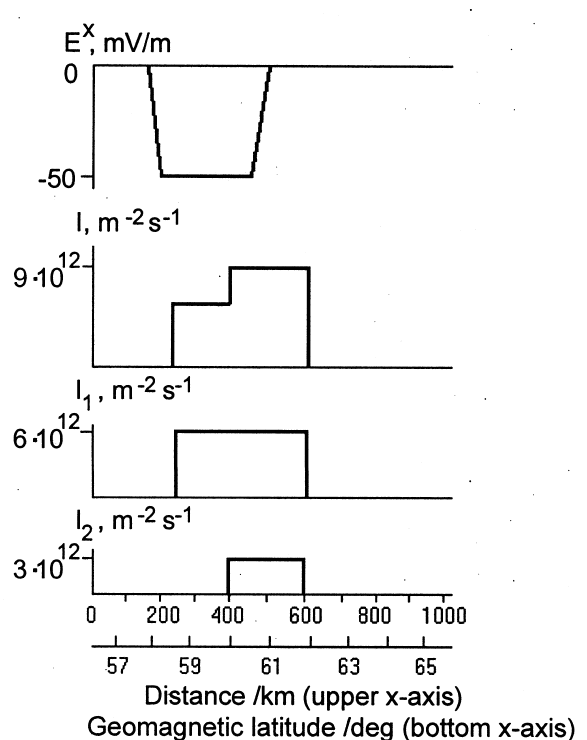
Fig. 5. Latitudinal dependence of the model input parameters at the upper boundary of the region of model simulation for the pattern in the bottom panel of Fig. 4: E x is the meridional component of the electric field, I = I 1 + I 2 is the total flux of precipitating electrons, and I 1 and I 2 are the fluxes of precipitating electrons with energies of 1 keV and 0.2 keV,